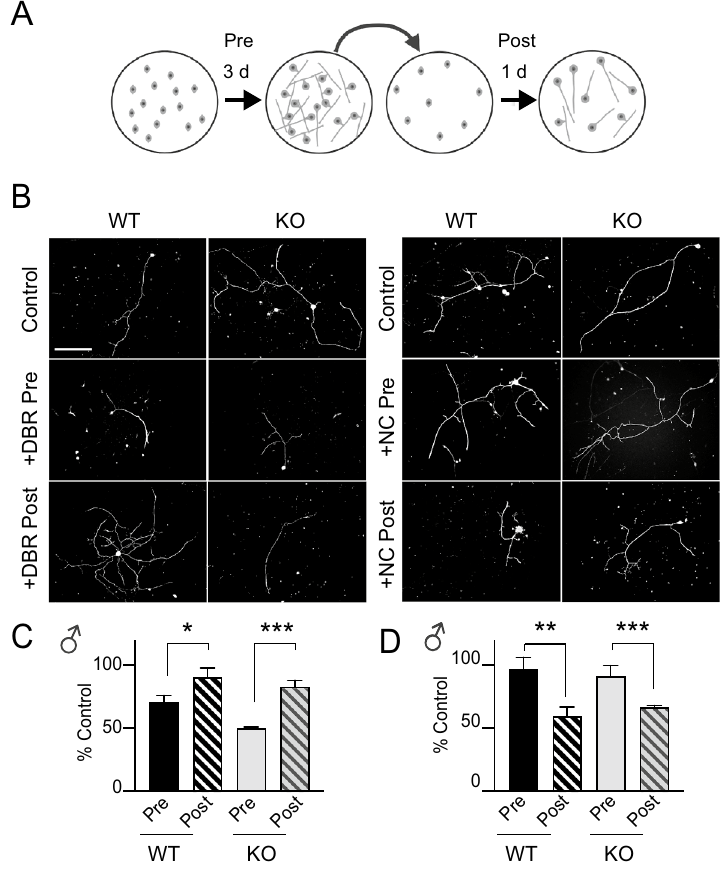
Figure 2. In vitro axotomy assay for analyses of neurite regeneration and growth. ( A ) Schematic of the in vitro axotomy assay. DRGNs were cultured for 3 d prior to replating and culture for 1 d before immunolabeling with NF200 antibodies. ( B ) Representative confocal images of DRGNs from WT or caldendrin KO male mice cultured with control medium or medium containing DBR (40 µM) or nocodazole (NC, 50 µM) before (Pre) or after (Post) replating. Scale bars, 500 µm. (C,D) Maximal neurite length per DRGN in cultures exposed to DBR ( C ) or NC ( D ) was normalized to that in the control group (no drug) and plotted as % Control. Each point represents the average obtained from n = 33 DRGNs from 3 independent cultures. Error bars represent SEM. In C, * p = 0.0187, t(4) = 3.83; *** p = 0.0004, t(4) = 11.02. In D, ** p = 0.005, t(4) = 5.602; *** p = 0.0073, t(4) = 5.032. Significant differences were determined by unpaired